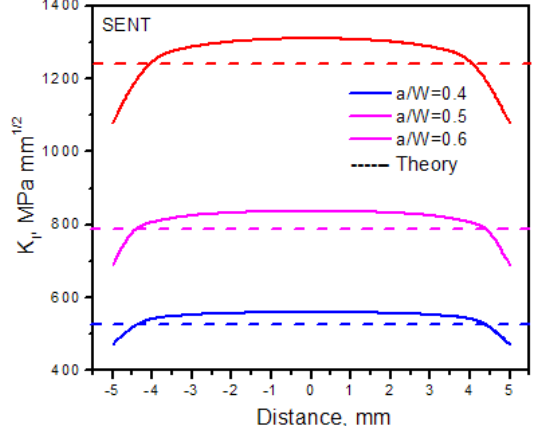
Figure 9: Variation of K I along the crack-front for various specimen thicknesses.